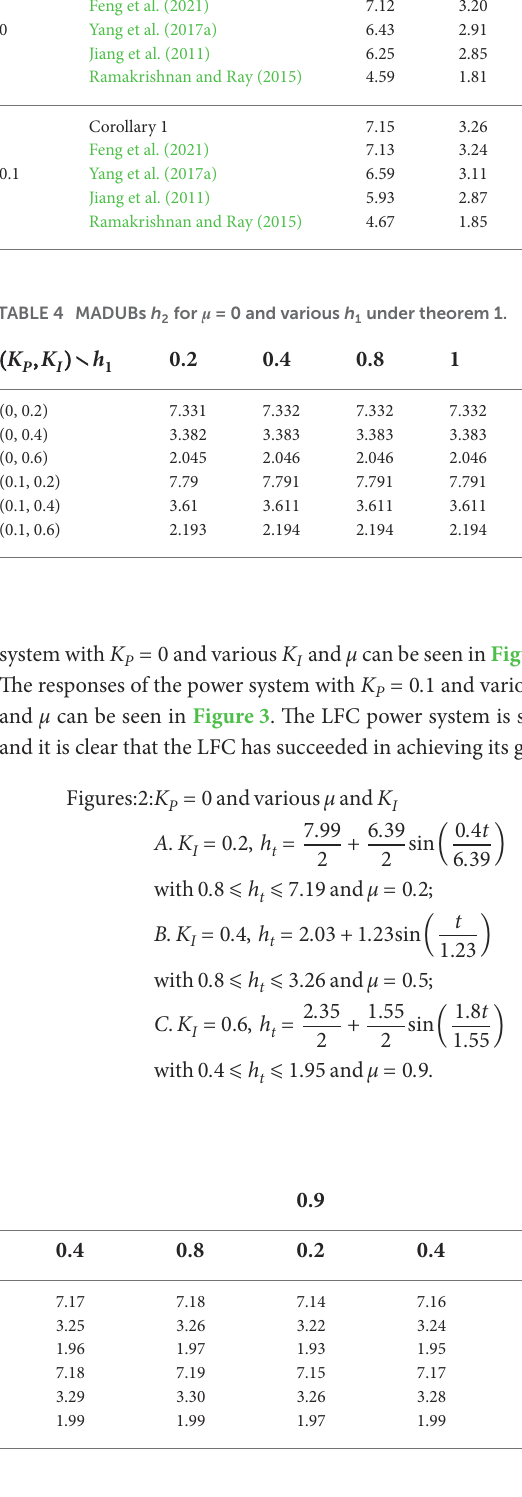
TABLE 2 MADUBs h 2 for fixed μ = 0 and various K P and K I .